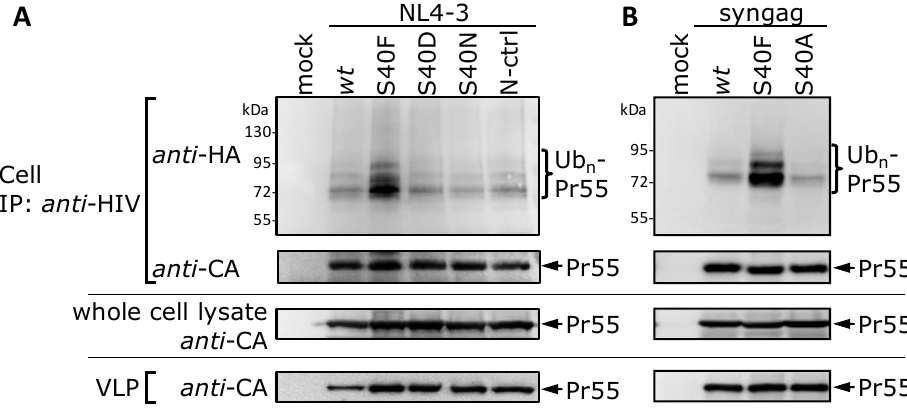
Figure 3. Influence of the S40N, S40D or S40A mutation on Gag ubiquitination. ( A ) HeLa cells were co-transfected with HA-tagged ubiquitin and pNL4-3 plasmids, as indicated. Gag processing was inhibited by the addition of the PR-inhibitor Ritonavir.